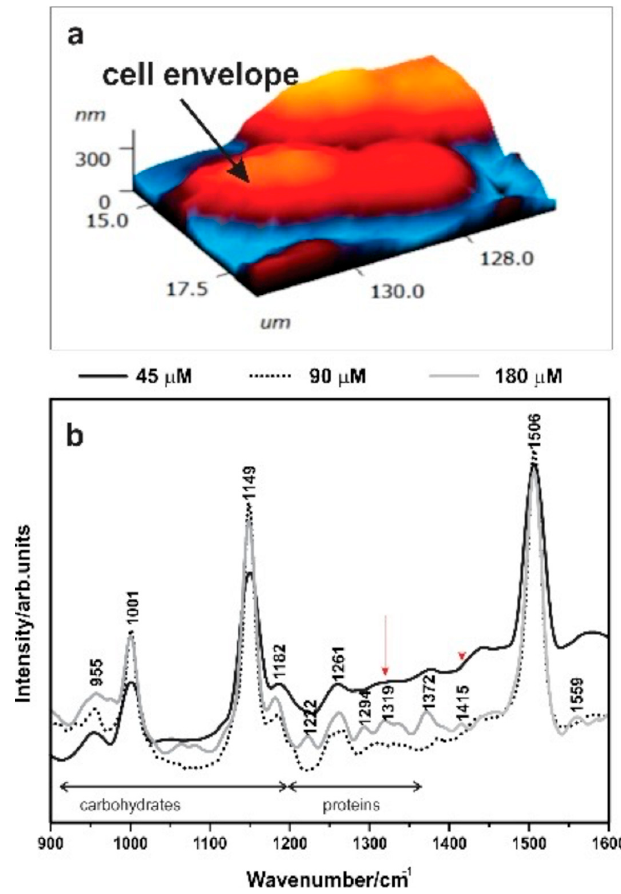
Figure 3. ( a ) Atomic force microscopy (AFM) of Synechococcus cells. ( b ) Tip-enhanced Raman spectroscopy (TERS) spectra of Syn . PCC8806 grown under different P.